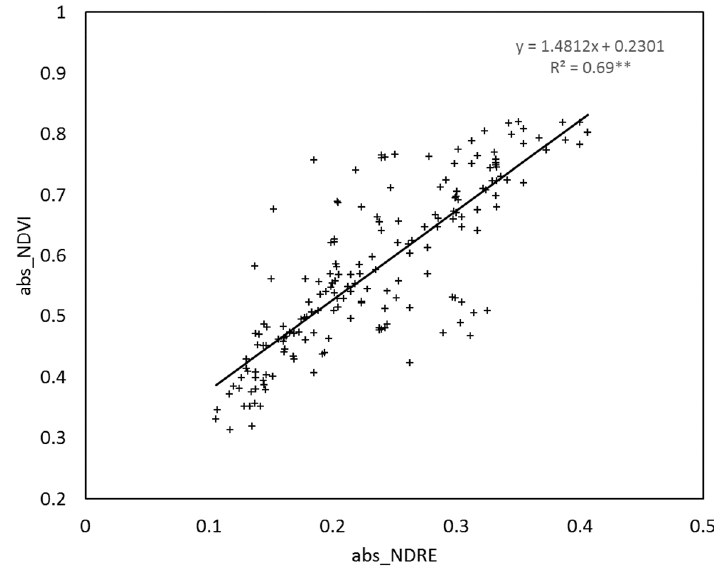
Figure 5. Relationship between the abs_NDVI and abs_NDRE values from the three growing seasons. abs, absolute values; nor, normalized values; NDVI, Normalized Difference Vegetation Index; NDRE, Normalized Difference Red Edge Index. **, significant at 0.01 probability level.